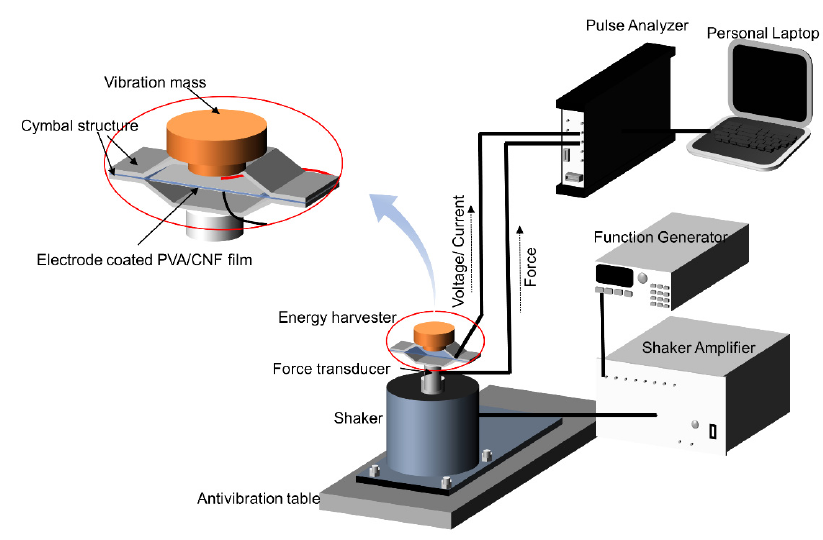
Figure 3. A schematic diagram of vibration energy harvesting and its test